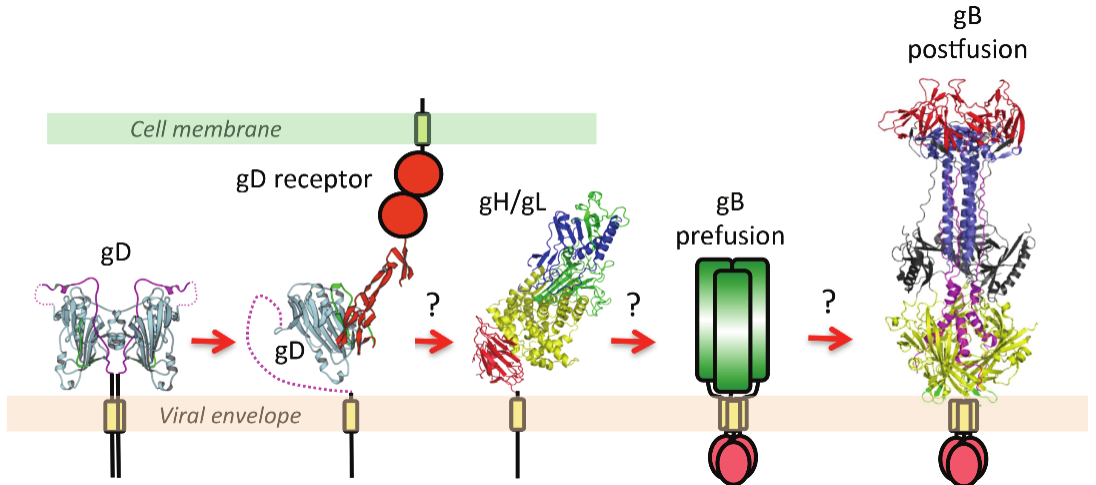
Figure 3. A schematic diagram of essential steps in HSV glycoprotein-mediated fusion. Crystal structures of apo gD (PDB ID 2C36), gD/HVEM complex (PDB ID 1JMA), gH/gL (PDB ID 3M1C), and the postfusion form of gB (PDB ID 2GUM) are shown. The prefusion form of gB has not yet been characterized and is shown schematically. Conformational changes in gD upon receptor binding are well documented. The order of subsequent steps has been proposed but not yet confirmed. Figure was made with Pymol.